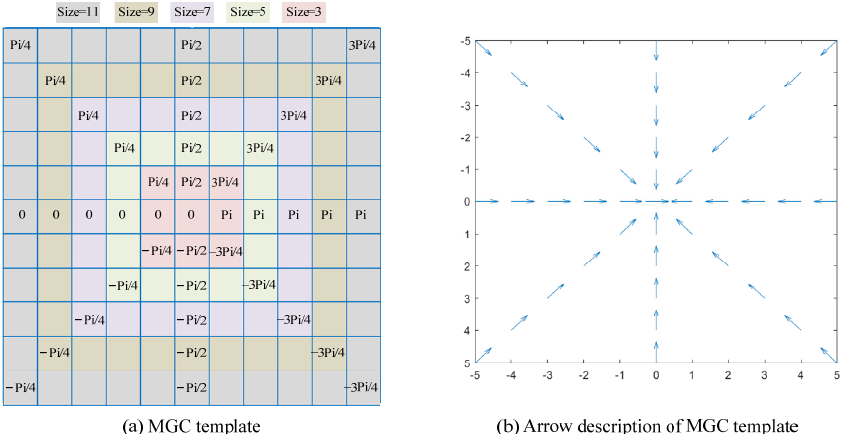
Figure 2. The MGC template.